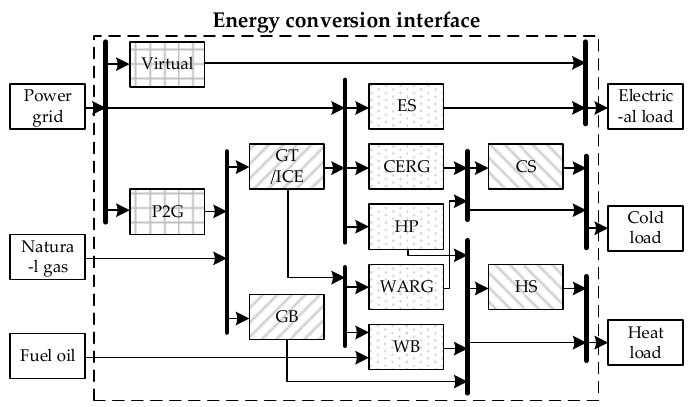
Figure 7. Schematic diagram of the optimal configuration of a campus ECI.